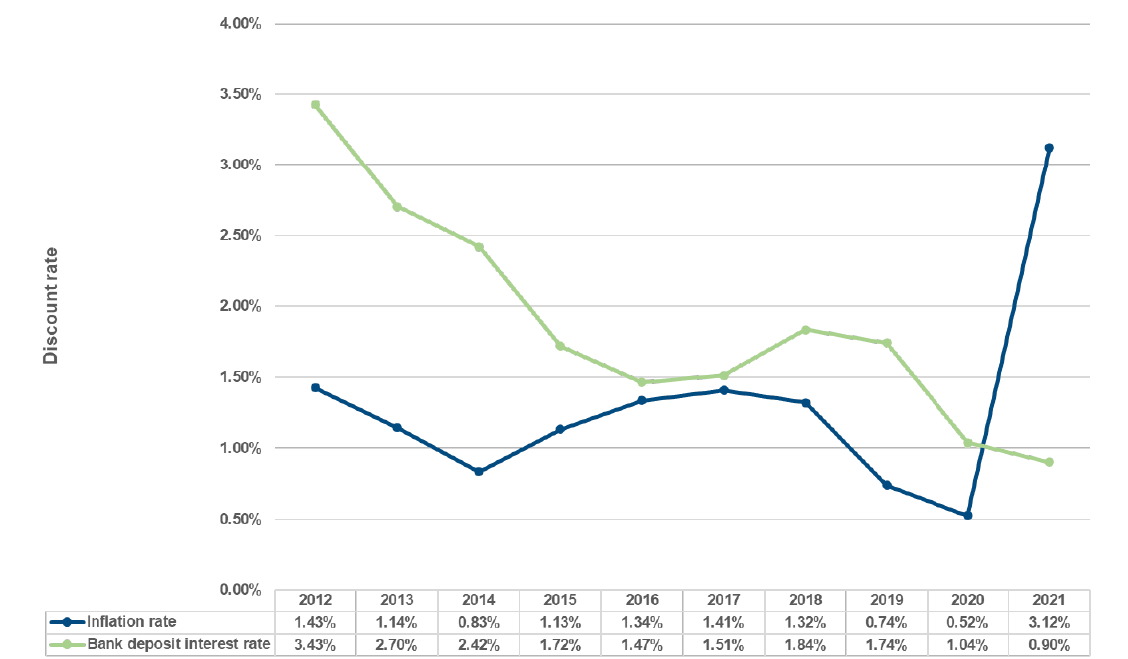
Figure 16. Inflation and bank deposit interest rates in Korea over the past 10 years (2012 – 2021).